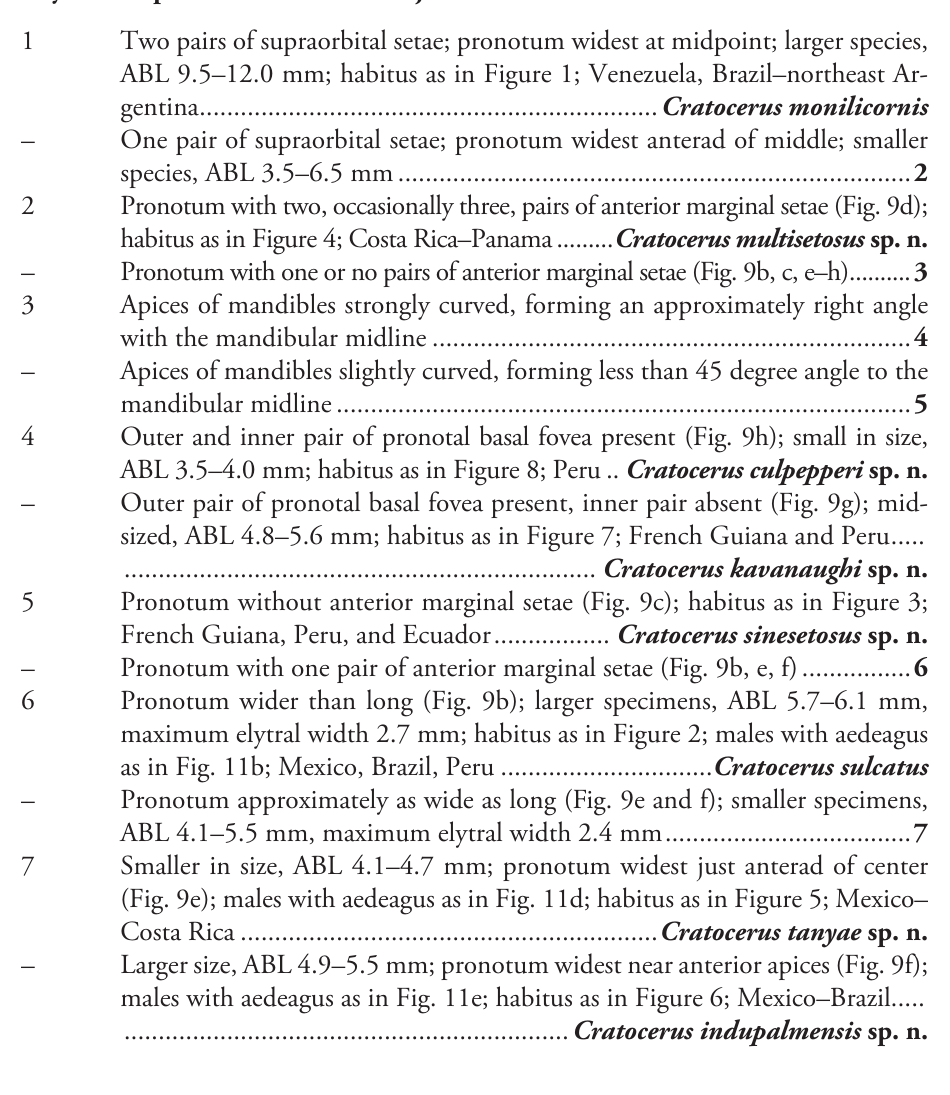
Smaller in size, ABL 4.1–4.7 mm; pronotum widest just anterad of center (Fig. 9e); males with aedeagus as in Fig. 11d; habitus as in Figure 5; Mexico– Larger size, ABL 4.9–5.5 mm; pronotum widest near anterior apices (Fig. 9f); males with aedeagus as in Fig. 11e; habitus as in Figure 6;